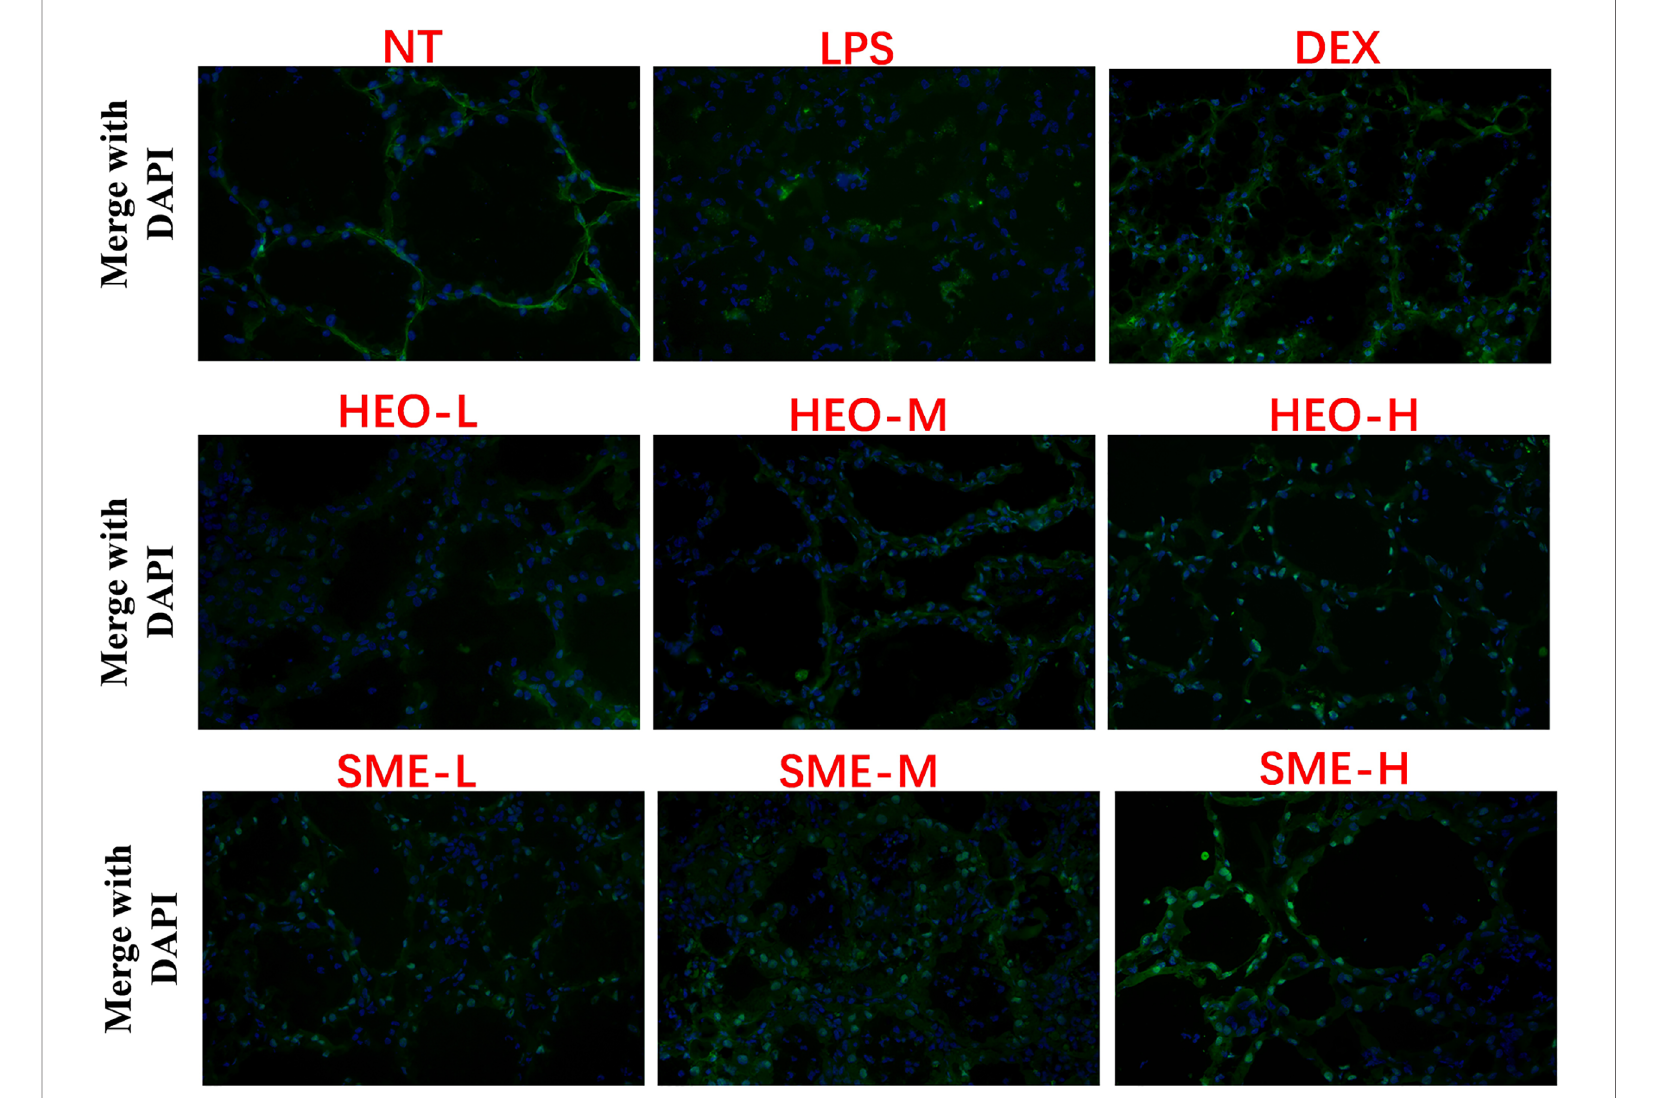
FIGURE 6 | Effects of HEO and SME-HEO on the blood – milk barrier in LPS-induced murine mastitis. Green and blue colors indicate FITC-albumin and nuclei,